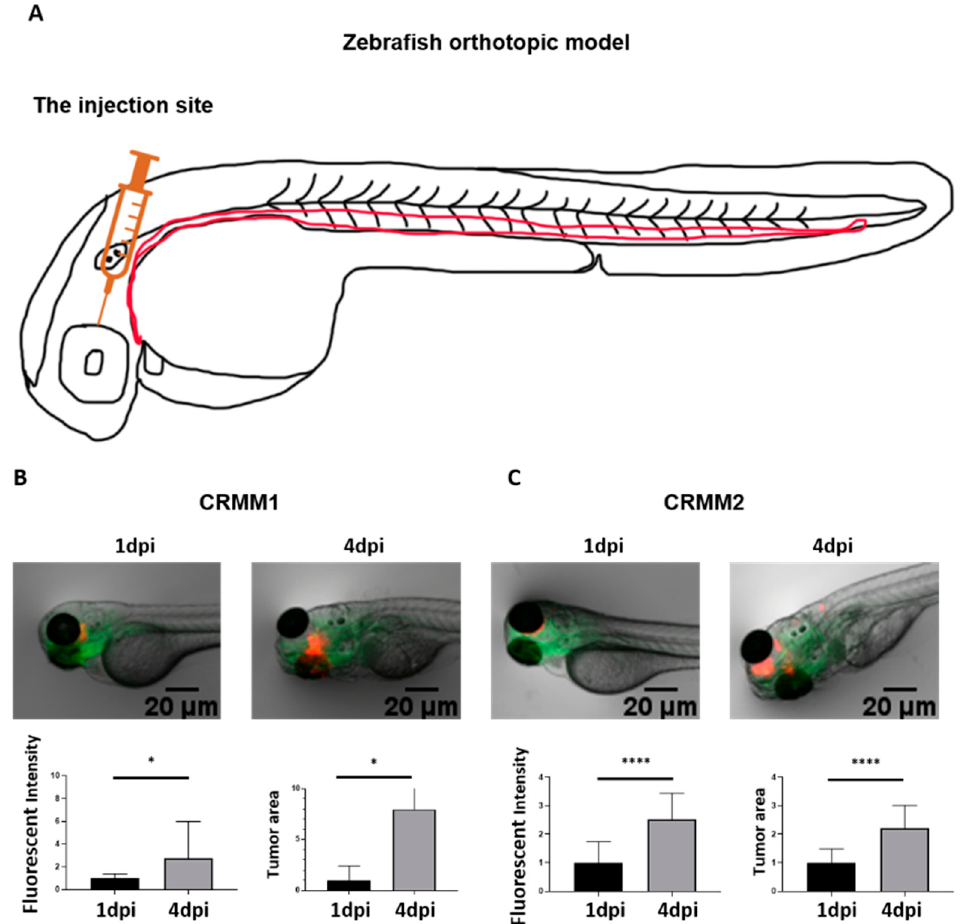
Figure 6. Development of a new conjunctival melanoma orthotopic tumour model in ZF. ( A ) Location of CM cell injection, ( B ) red fluorescent CRMM1 and (C) CRMM2 cells were injected RO into 2 dpf tg(Fli:GFP / Casper) ( n = 10) and imaged by fluorescence microscopy at 1 and 4 days post injection (dpi). Relative tumour burden was calculated as fluorescent intensity and area of tumour cells by Image J. Results are means ± SD of three independent experiments. Table 3. Relative tumour burden quantified by fluorescence intensity in zebrafish embryonic models after treatment with TLD1433, delivered by three di ff erent administration routes. The fluorescence intensity is calculated as percentage, compared to the control dark group